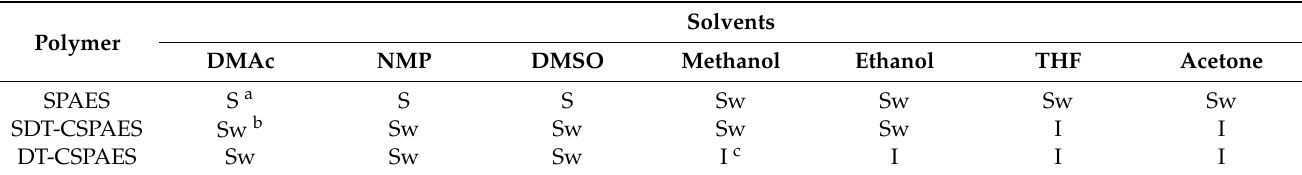
Table 2. Solubility test of SPAES, SDT-CSPAES and DT-CSPAES membranes.